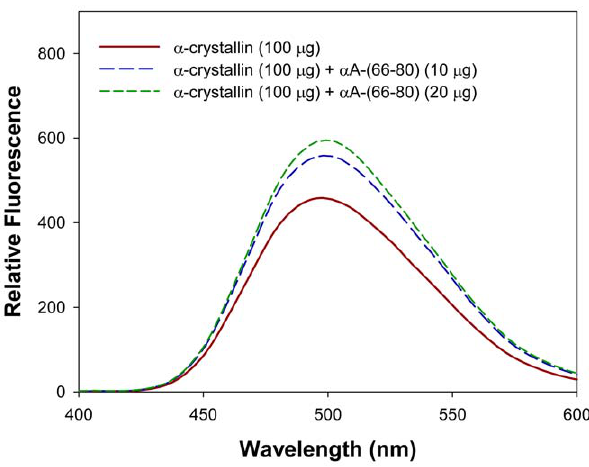
Figure 3. Bis-ANS binding to a -crystallin treated with or without a A-(66-80). a -Crystallin (100 m g) purified from a bovine lens extract was incubated with and without 10 or 20 m g of a A-(66-80) peptide in 50 mM phosphate buffer, pH 7.2 for 60 min and 10 m L of 20 mM bis-ANS prepared in 5% ethanol was added. Fluorescence was recorded after excitation at 390 nm in a Jasco FP750 spectrofluorom- eter. The fluorescence for a A-(66-80) was subtracted from the spectra for the complexes. These data show that the interaction of this peptide with a -crystallin leads to an overall increase in the hydrophobicity of the complex. PLoS ONE |